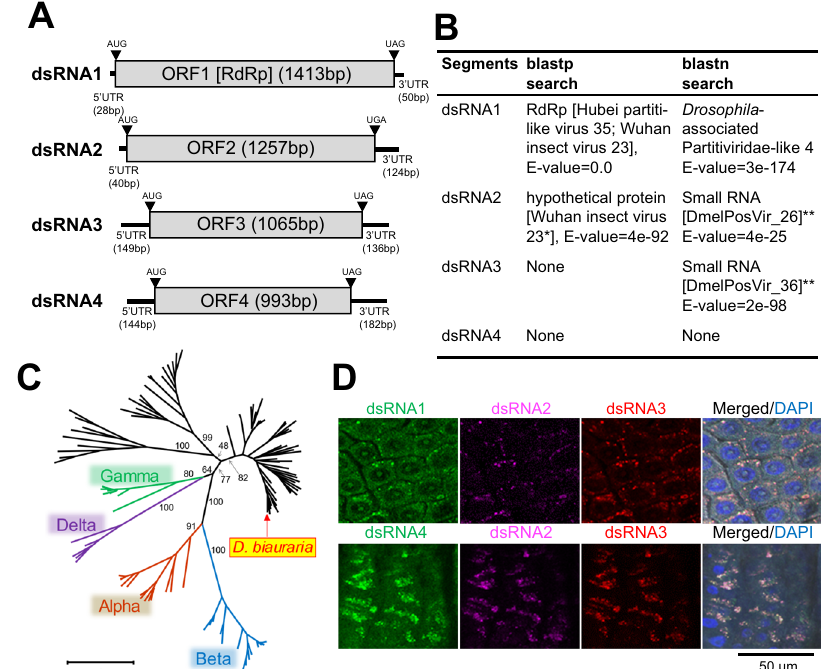
Fig.2| Causalagentofthemale-killing.A OrganizationoffourdsRNAsequences (dsRNA1 – dsRNA4) identi fi ed in SP12F and tr.SP11-20 lines. Gray boxes: putative open reading frames (ORFs). Bars: putative untranslated regions (5 ʹ UTR and 3 ʹ UTR). Black triangles: start codons (AUG) and stop codons (UAG and UGA). B Results of database search for the four dsRNAs. *Considered Partitiviridae because the other segment of the Wuhan insect virus 23 is homologous to Parti- tiviridae RdRp (Shi et al., 2016). **Putative viral sequences identi fi ed in Drosophila (Webster et al., 2015). C Unrooted phylogenetic tree of family Partitiviridae based on amino acid sequences of RNA-dependent RNA polymerase (RdRp). Colored branches indicate known partitiviruses (Alpha: Alphapartitivirus, Beta: Betapartiti- virus,Gamma:Gammapartitivirus,Delta:Deltapartitivirus).Blackbranchesindicate Partiti-like virus sequences deposited as transcriptome shotgun assembly from